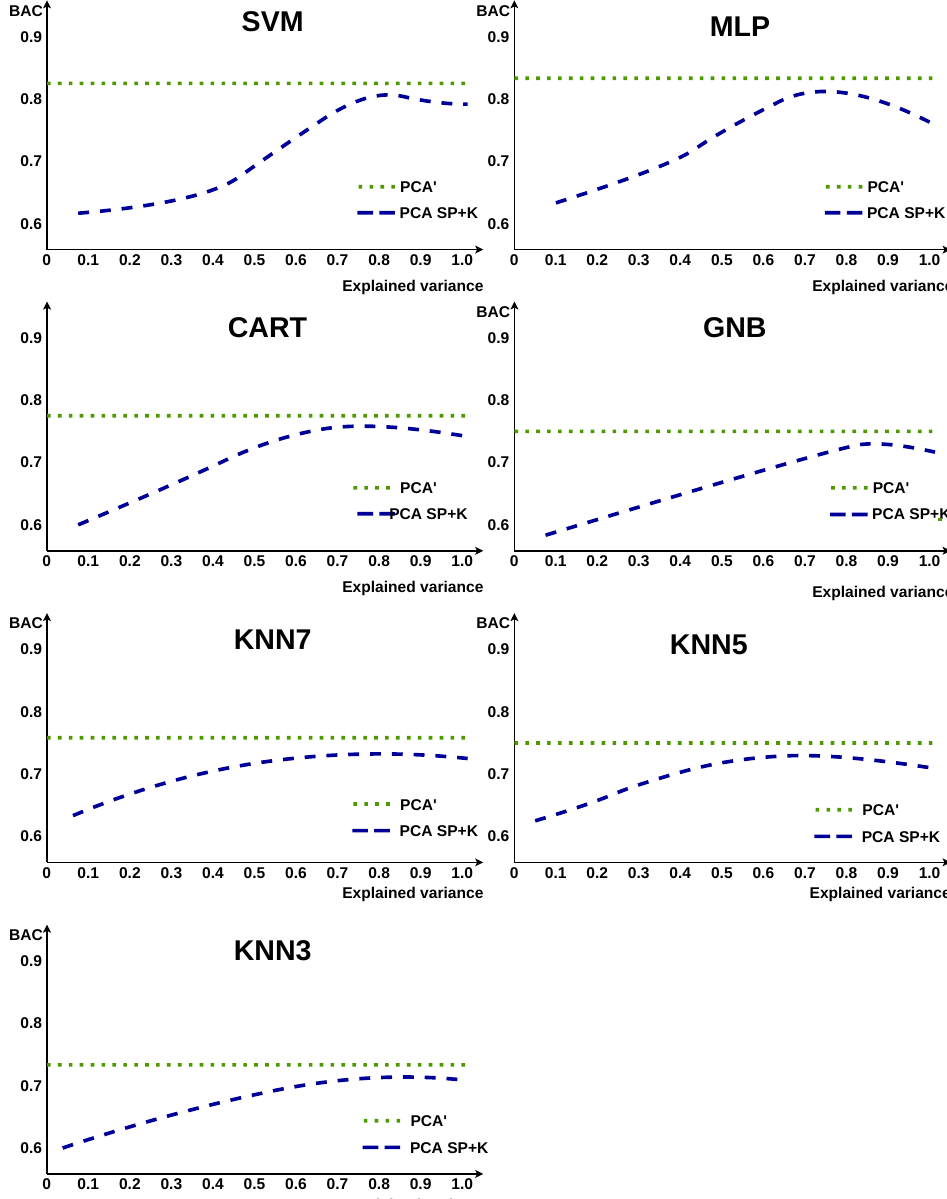
Figure 5. The results of the experiment 2, classification quality depending on the percentage of explained variance for PCA with the BAC- score metric. The results were compared with the PCA (cid:48)